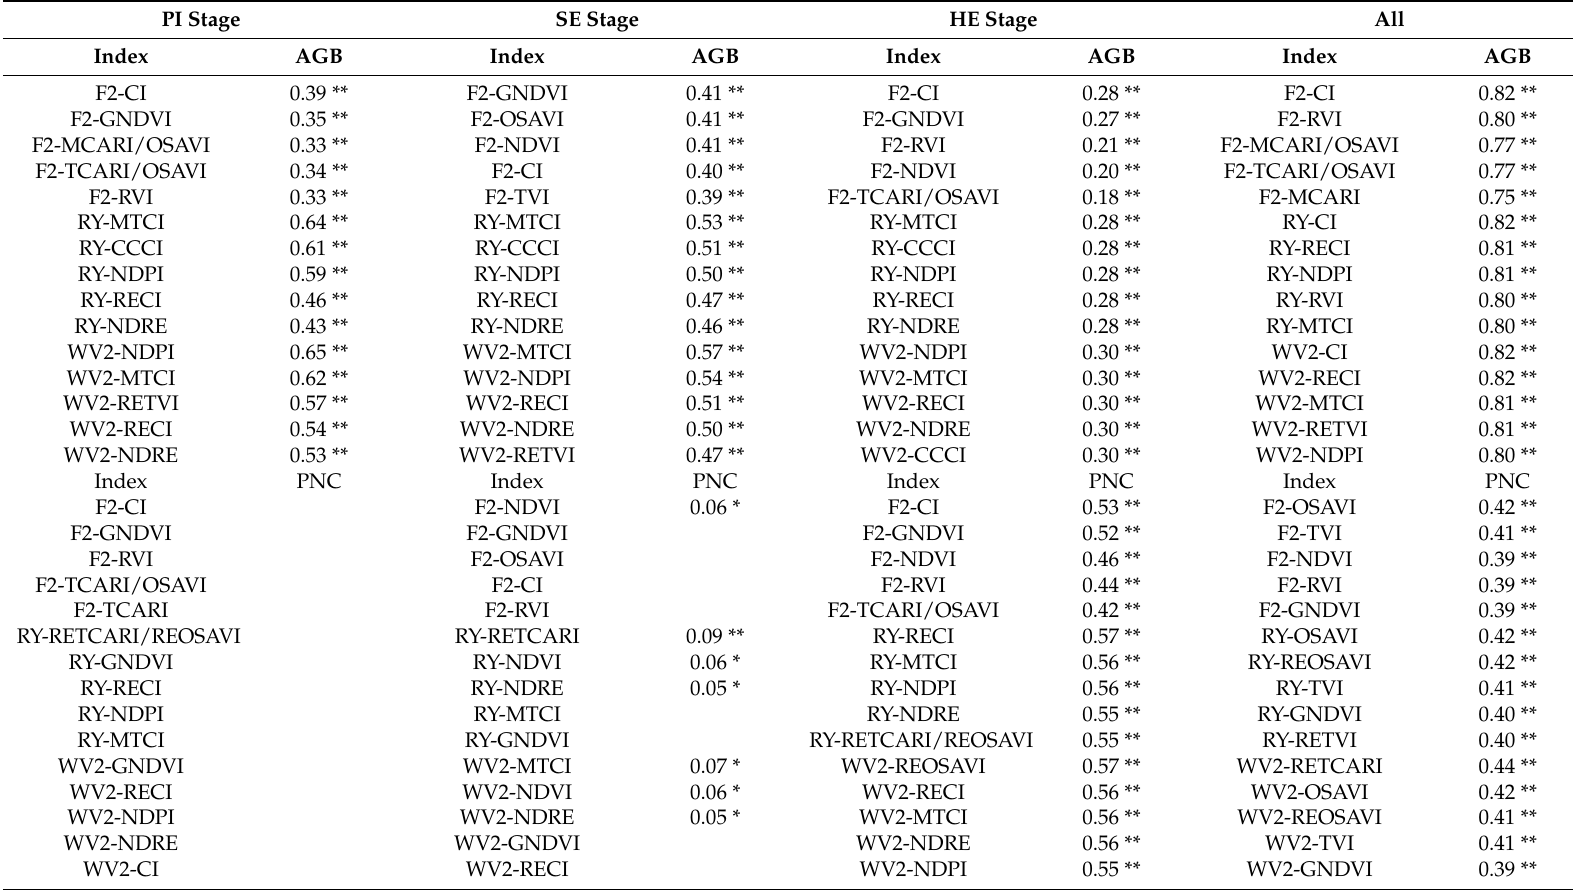
Table 5. The top five coefficients of determination (r 2 ) for the relationships between vegetation indices based on the wavebands of FORMOSAT-2 (F2), RapidEye (RY), WorldView-2 (WV2) and aboveground biomass (AGB), plant N concentration (PNC) at the panicle initiation (PI), stem elongation (SE), heading (HE), and across stages (All), respectively. Only significant r 2 values were